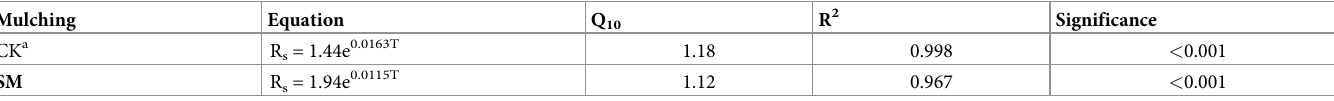
Table 3. Regression equations between cumulative Soil Respiration (R s ) and incubation Temperature (T) under no mulching and straw mulching. Mulching Equation Q 10 R 2